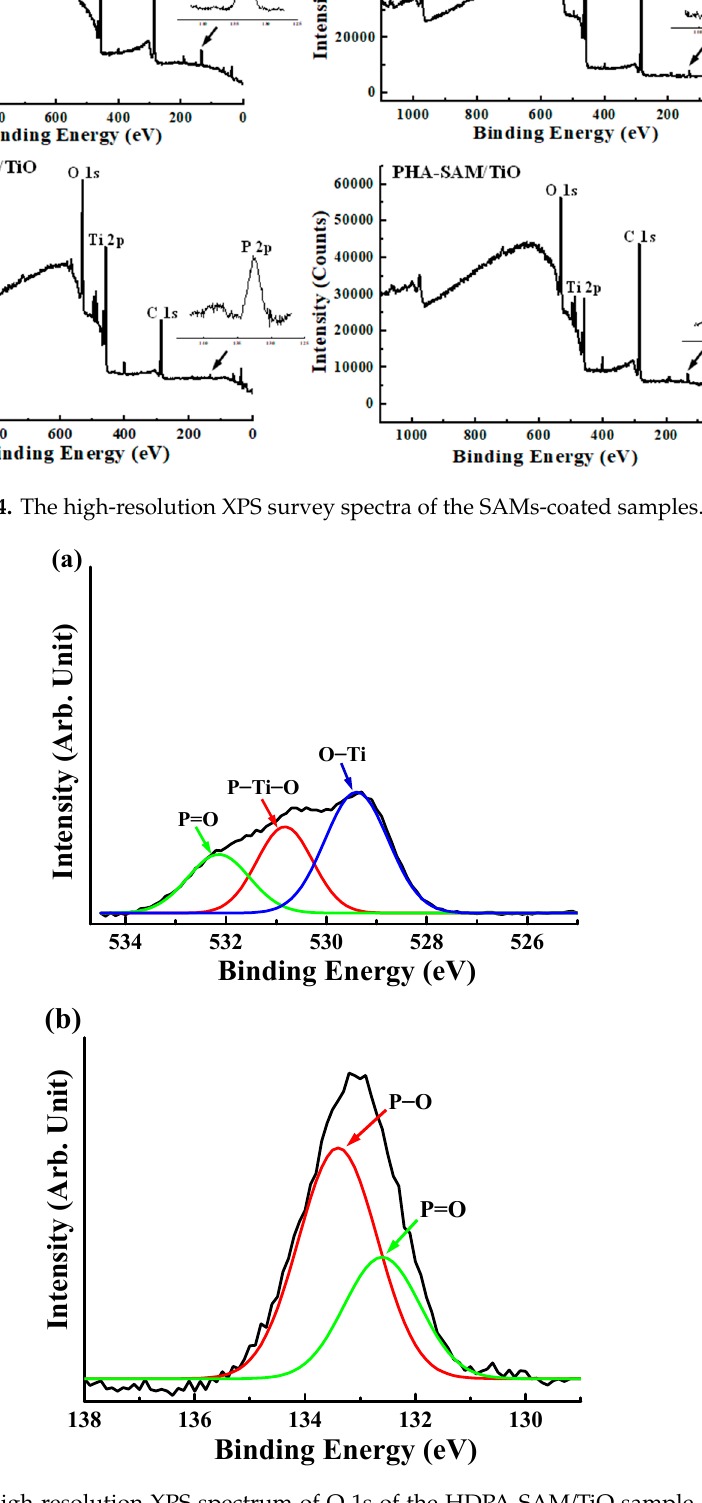
Figure 5. ( a ) the high-resolution XPS spectrum of O 1s of the HDPA-SAM / TiO sample and ( b ) the regional scans of P 2p peaks taken from the HDPA-SAM / TiO sample surface.